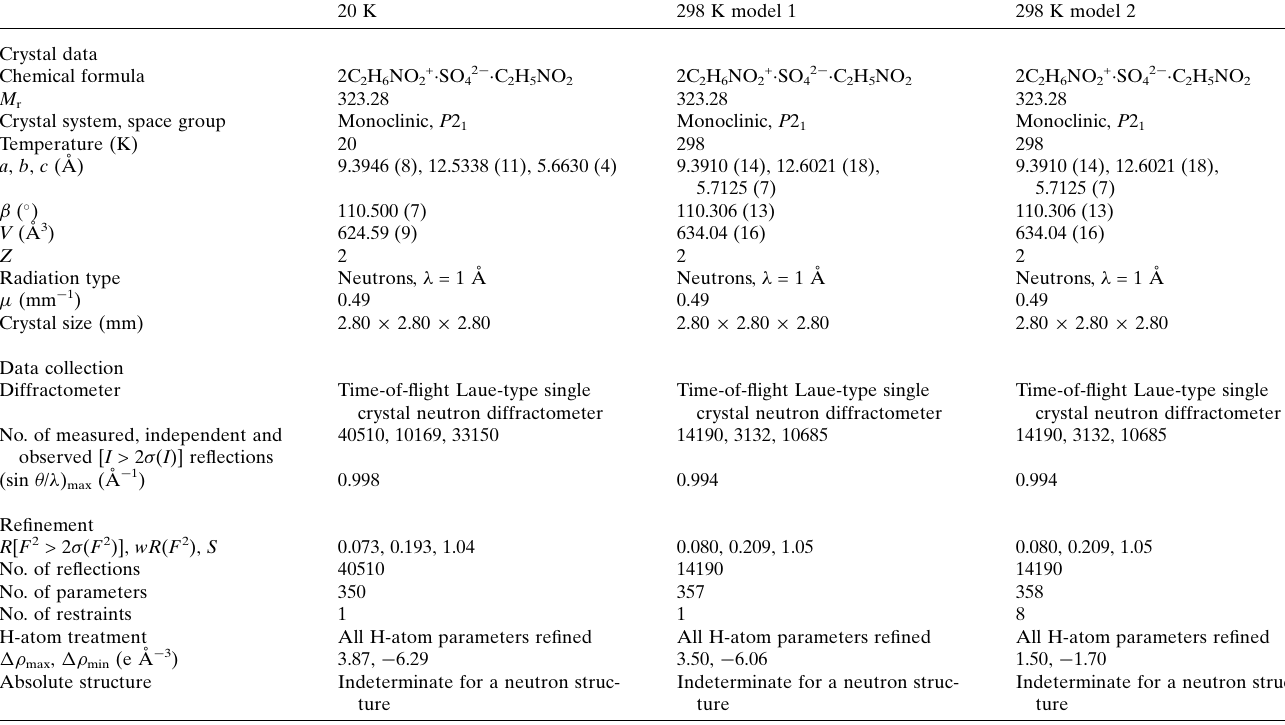
Table 3 Experimental details.